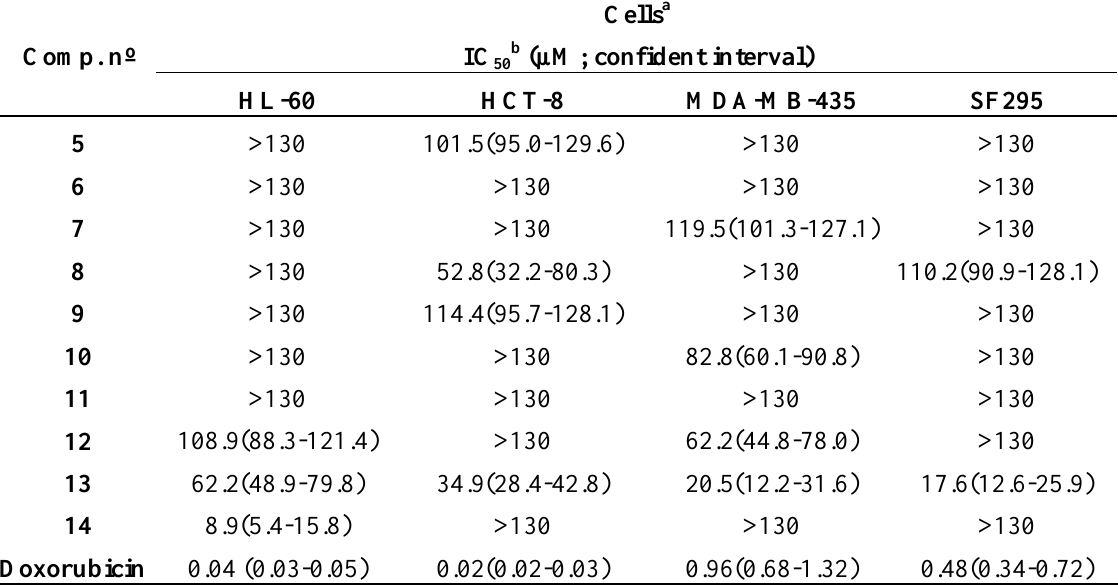
Table 1 – Cytotoxic activity of compounds 5-14 on human tumour cell lines. Doxorubicin was used as positive